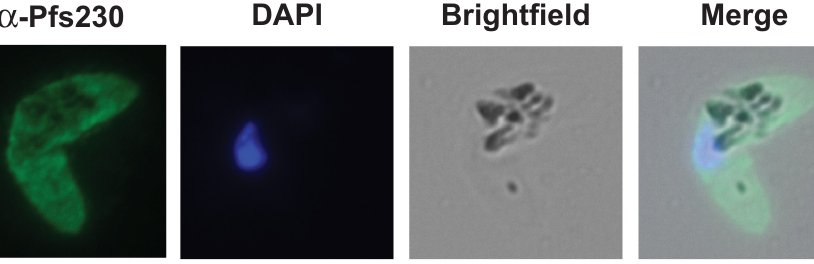
recombinant Pfs230D1M or Pfs25 protein. Further, rabbit antibodies generated against flow cytometry and this was also visualised by immunofluorescence microscopy. Importantly, rabbit antibodies against Pfs230D1M-dS/dS and Pfs25-dS/dS VLPs were capable of blocking mosquito infection measured through standard membrane feeding assays.